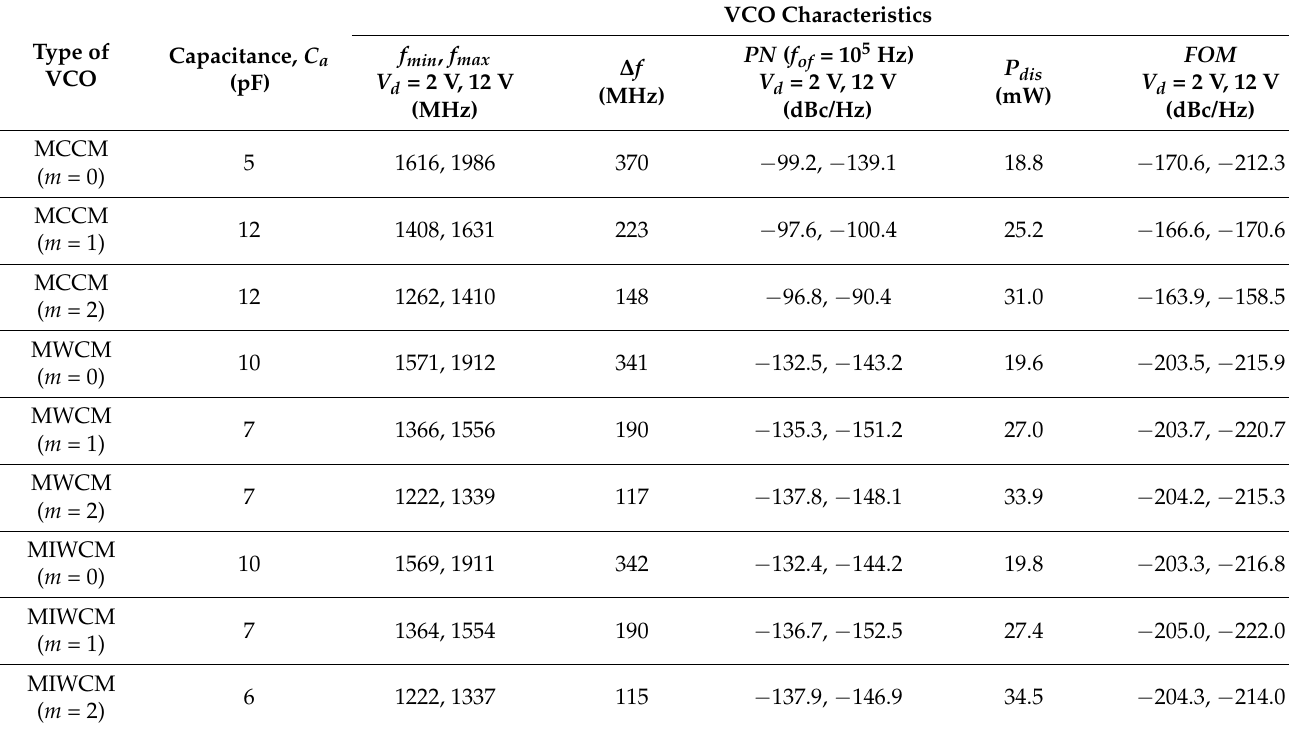
Table 11. Simulated characteristics of different NDR VCOs when R L = ∞